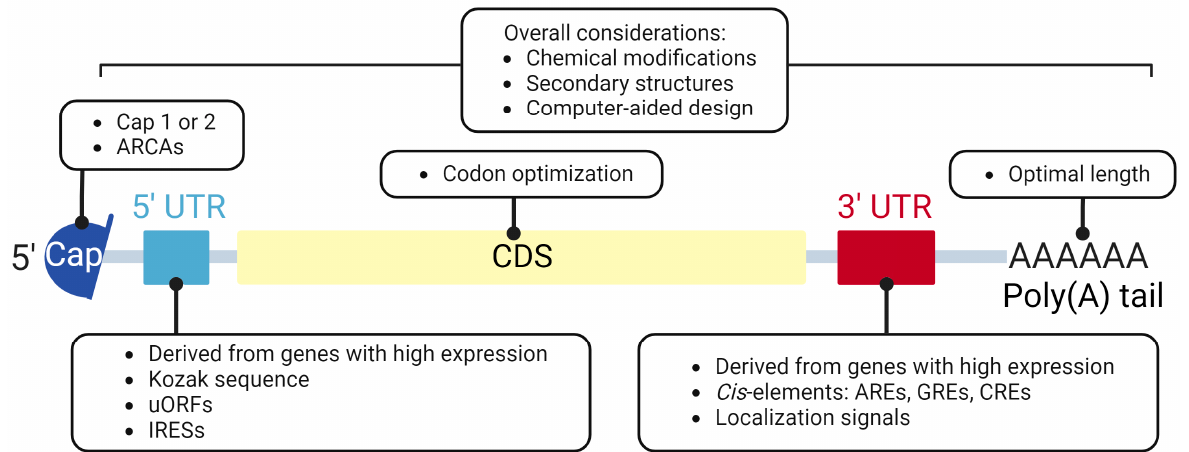
Figure 1. Structure and design considerations of IVT mRNAs.